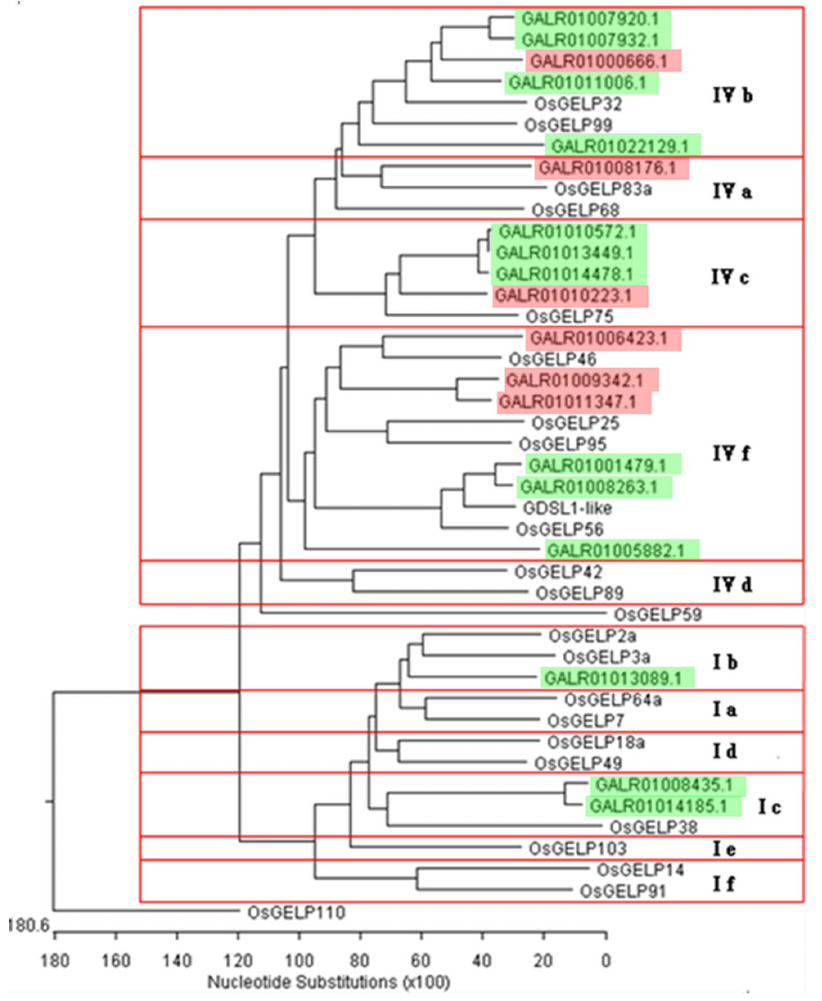
Figure 5. The phylogenetic relationship of the sand pear GDSL esterase/lipase genes ( GELPs ) differentially expressed between the green- (S1) and the russet-pericarp (S2) pools. The tree was constructed based on multiple sequence alignment of sand pear and rice GELP protein sequences using ClustalW program by NJ method with 1,000 bootstrap replicates. The different types of rice GELPs (Chepyshko et al ., 2012) were used as the reference in the phylogenetic analysis. Subclades are numbered at the right part of the tree according to the rice results by Chepyshko et al . (2012). The sand pear GELP s marked in red or green show relative higher and lower transcript level in the russet pericarp pool library, comparing with that of the green pericarp pool library.